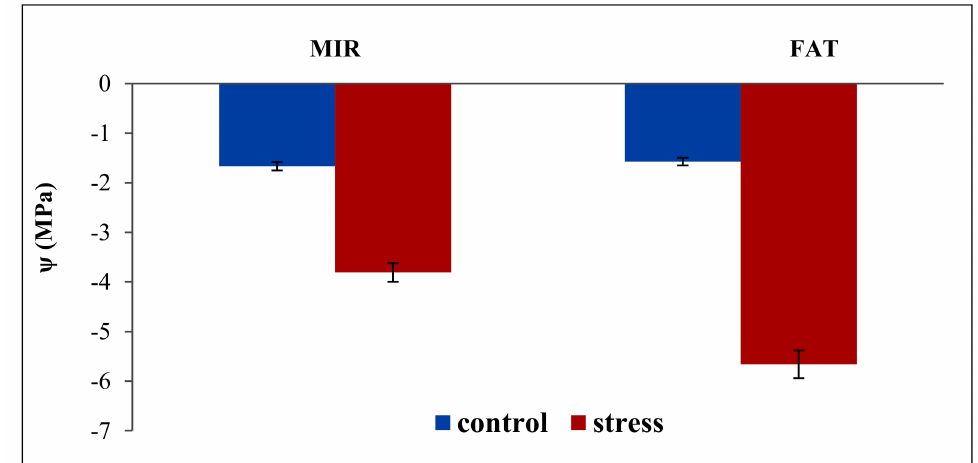
Figure 2. Effect of 150 mM NaCl on osmotic potential ( ψπ ) in the leaves of the salt-tolerant Mirbashir 128 (MIR) and salt-sensitive Fatima (FAT) wheat genotypes after 10 days of salt treatment. The values of standard error ( ± SE) in each bar were calculated for each treatment from three replications.